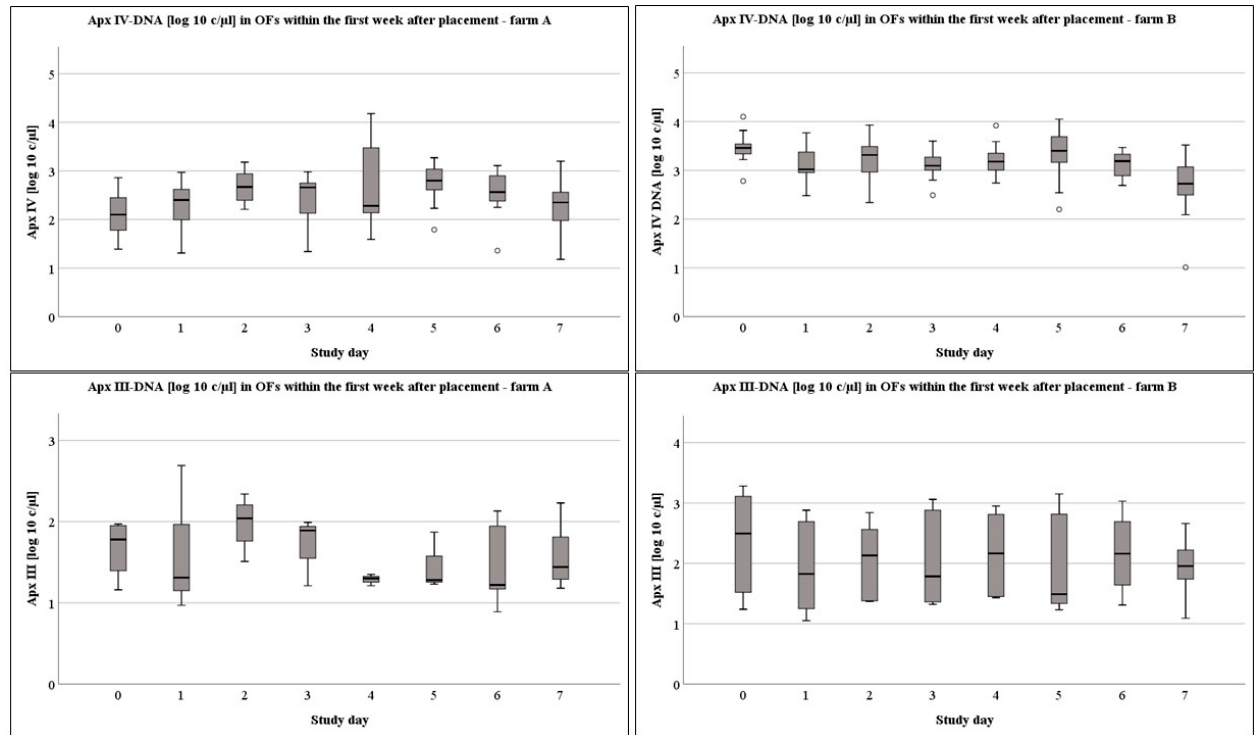
Figure 2. Boxplots of log10 c/µL Apx IV- and Apx III-toxin DNA in OFs from placement until 7 days after placement from farms A and B.